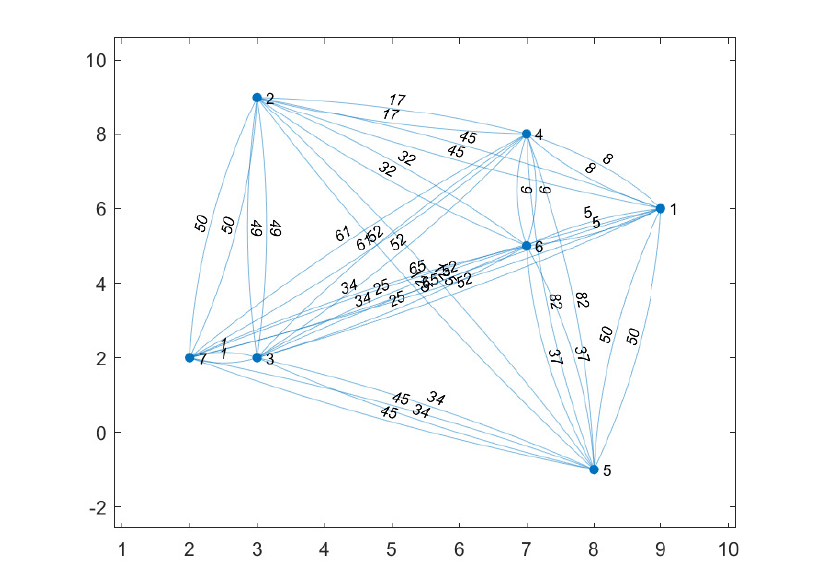
Figure 5. Nodes show that the locations of the seven CH robots. The weight of a link shows the square of distance between the two nodes connected via that